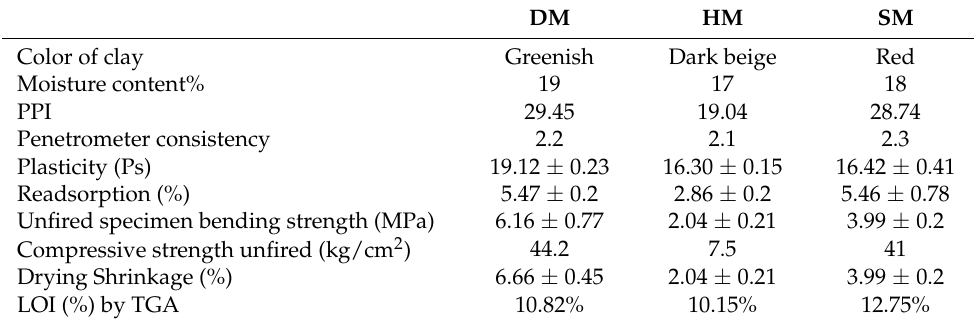
Table 5. Technological features of clays and unfired brick